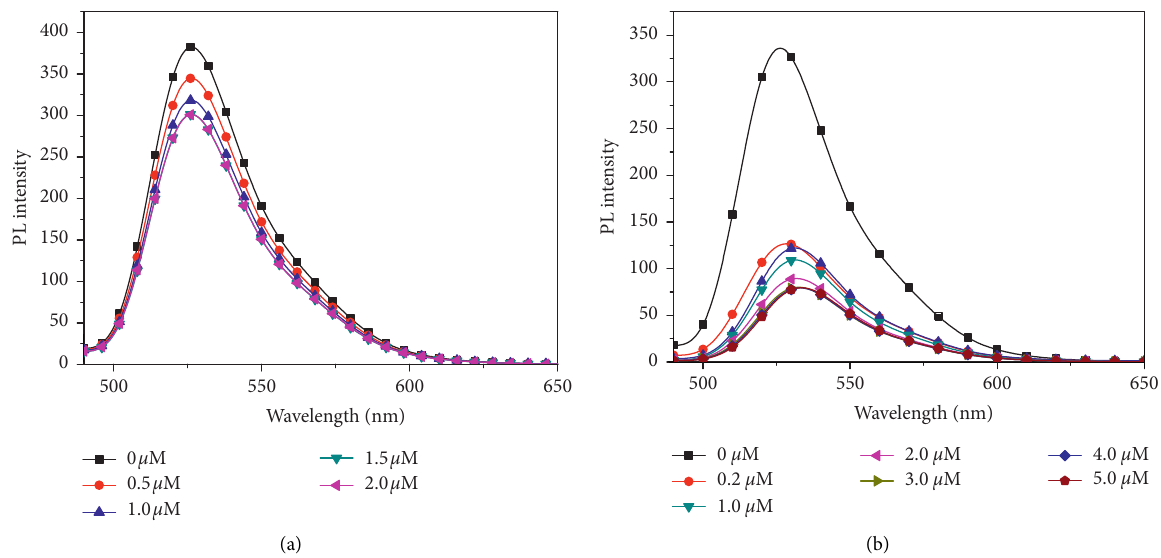
Figure 12: The emission of ssDNA-FAM in the presence of P4 (a) and P4 ′ (b) excitation at 480nm.